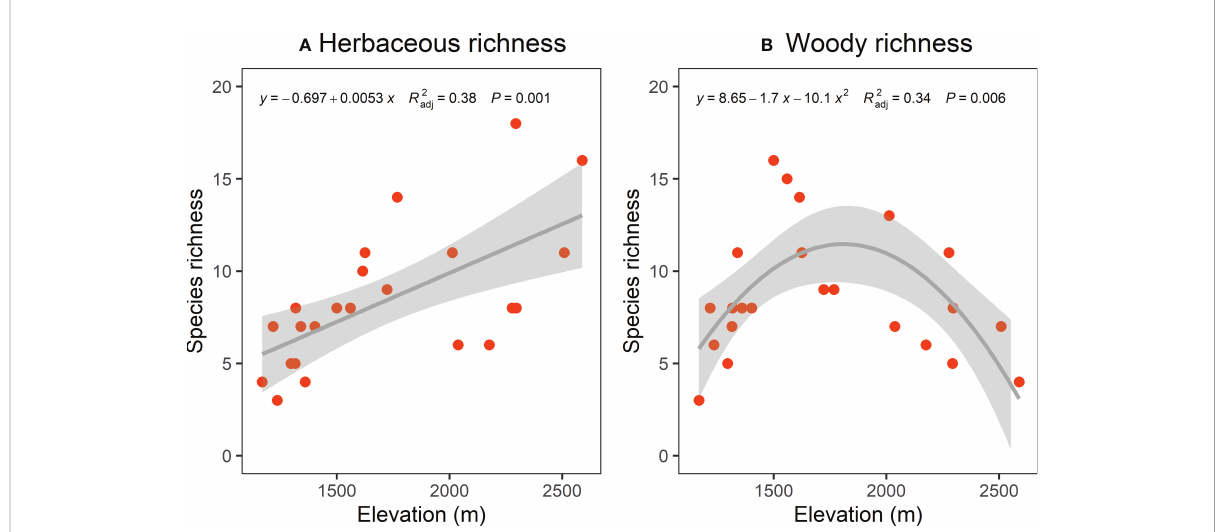
FIGURE 2 Elevational patterns of species richness of herbaceous (A) and woody (B) . Trend lines and shaded areas represent the fi tted values from linear regression with a linear term (A) and quadratic (B) and their 95% con fi dence intervals, respectively.